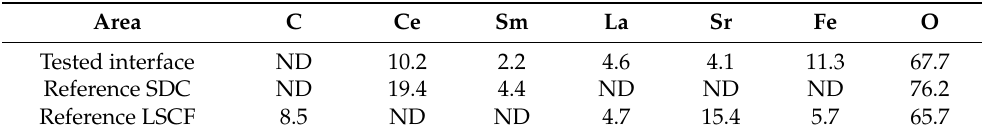
Table 4. Elemental composition (atomic%) of the tested interface, reference SDC and reference LSCF obtained by XPS. Adventitious carbon, cobalt and residual chlorine were removed from the elemental composition. ND (Non